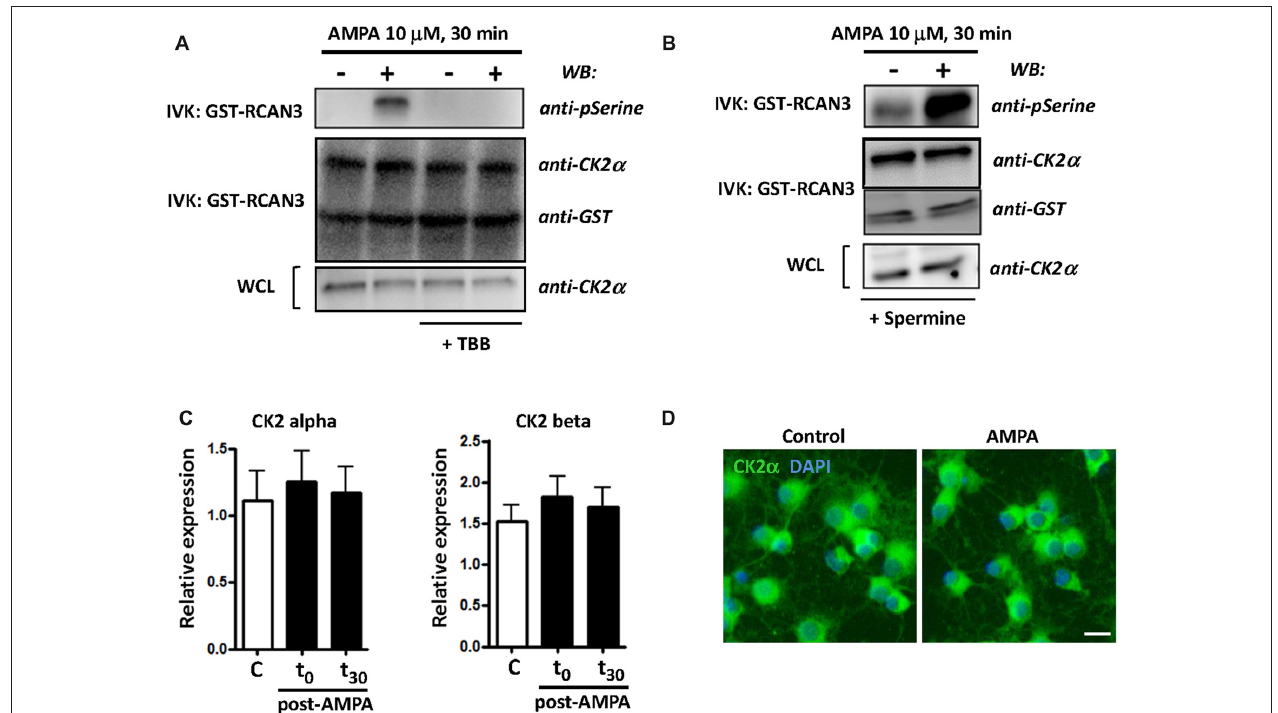
FIGURE 1 | AMPA receptor stimulation increases casein kinase 2 (CK2) activity in oligodendrocytes. Cultured rat oligodendrocytes obtained from mixed glial cultures were pre-incubated with 5 µ M TBB (A) or 10 µ M spermine (B) and the excitotoxic insult (10 µ M AMPA plus 100 µ M CTZ) was performed for 30 min. In all cases, cells were lysed after 30 min post-stimulus. (A,B) CK2 was immunoprecipitated with 2 µ g of anti-CK2 α antibody and in vitro CK2 phosphorylation assay was performed using recombinant GST-RCAN3 in presence of 200 µ M ATP (as described in “Materials and Methods” section). Immunocomplexes were subjected to in vitro kinase assay (IVK) followed by SDS-PAGE/immunoblotting (western blot, WB) and kinase activity were visualized using anti-phosphoserine antibody. In addition, the amount of CK2 α and GST-RCAN3 present in each immunocomplex and the expression level of CK2 α in whole cell lysates (WCL) were also determined by WB. Results are representative of three independent experiments. (C) mRNA for CK2 α and CK2 β subunits was analyzed by real-time qPCR, and relative expression of mRNA is shown. Analyses were performed in cultured oligodendrocytes treated with AMPA for 30 min and then mRNA was immediately extracted (t 0 ) or 30 min later (t 30 ). The data showed no significant modifications in CK2 expression levels at the time points evaluated. Values represent mean ± SEM ( n = 3). (D) Immunofluorescence analysis of CK2 α expression in cultured oligodendrocytes. Untreated control cells and treated for AMPA receptor activation were processed for CK2 immunofluorescence using the anti-CK2 α antibody described before (green), and nuclei were stained with DAPI (blue). The staining was performed at 30 min post-stimulus and it could be observed that exposure to AMPA did not cause significant changes in CK2 α protein expression levels, compared with control cells. Scale bar, 10 µ